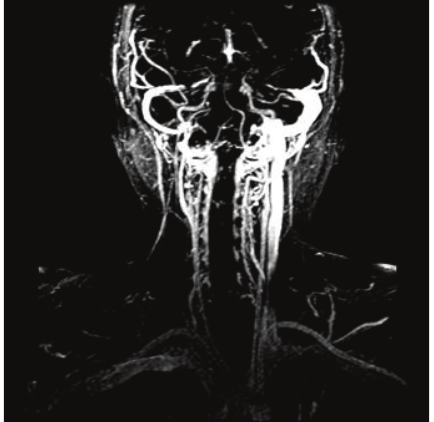
Figure 3: Sagittal view of collateral system (dynamic magnetic res- onance